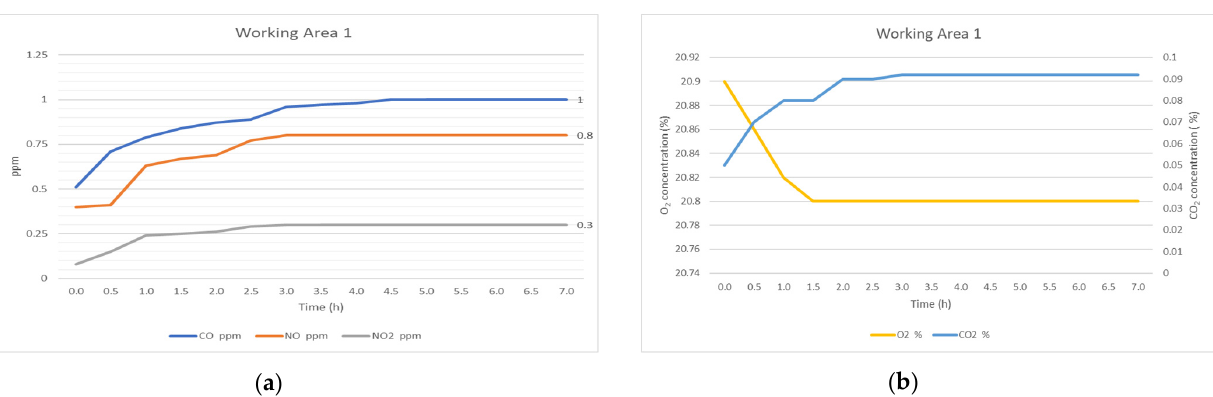
Figure 6. Results of a 7 h gas simulation at working area 1. ( a ) CO, NO and NO 2 in ppm; ( b ) O 2 and CO 2 expressed in percent.